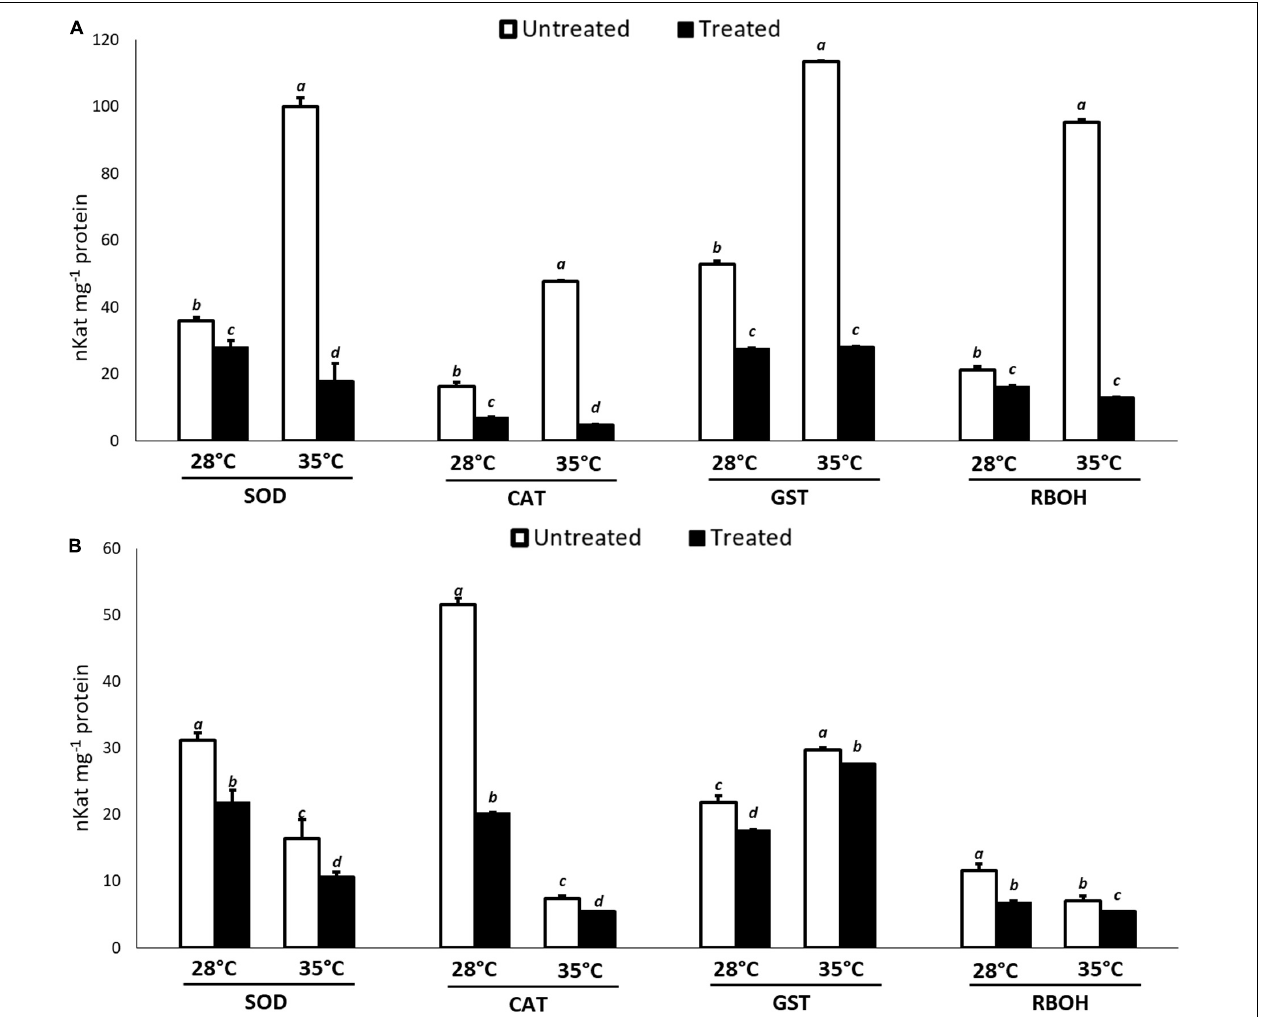
FIGURE 2 | Effect of KIEM R (cid:13) on enzymatic activities of RBOH, SOD, CAT, and GST at 24 (A) and 48 h (B) after seed incubation. Values are expressed as nKat mg − 1 protein. Bars represent the mean ± SD of three different biological replicates. For each bar, different lowercase letters indicate significant differences ( p ≤ 0.05), as measured by one-way ANOVA followed by Tukey’s post hoc